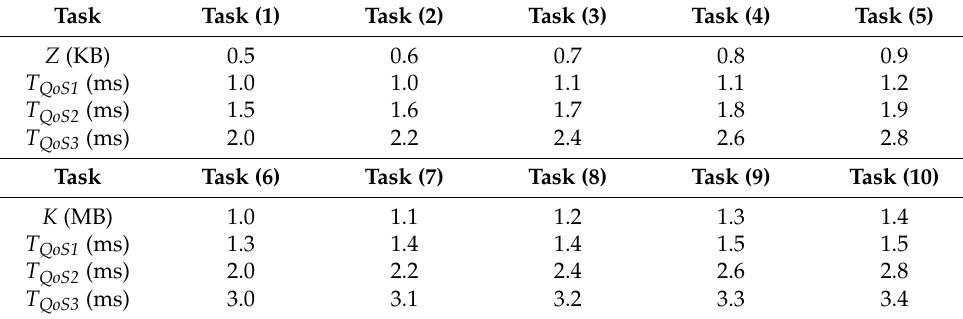
Table 5. Task specifications of IoT